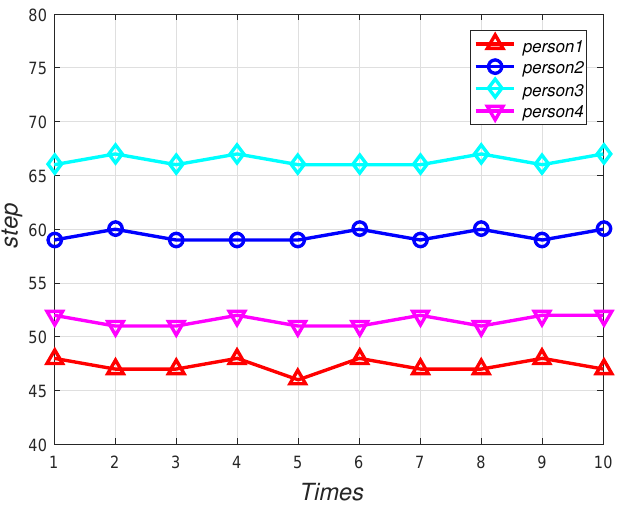
Figure 3. Preliminary experiment of